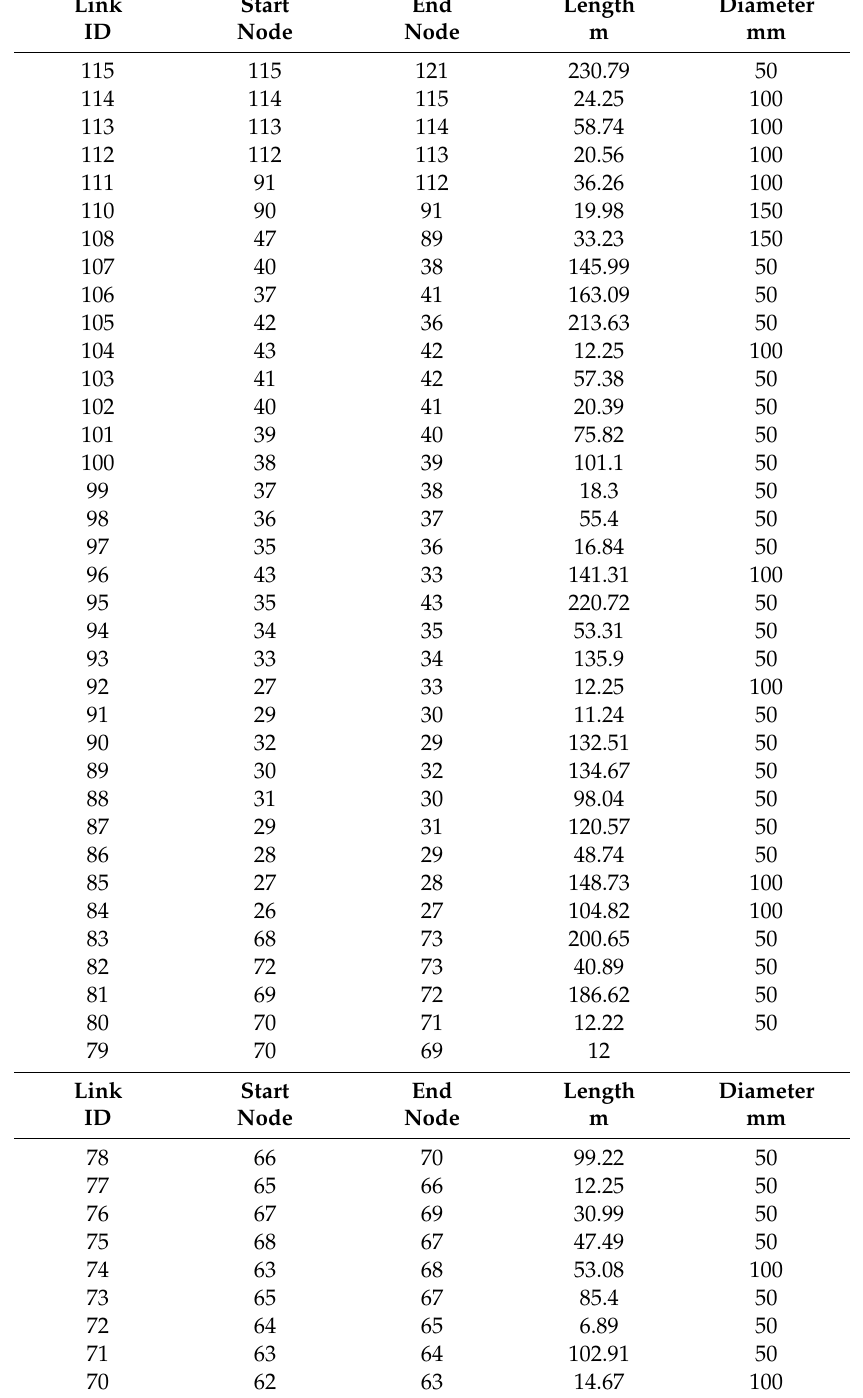
Table A1. Pipeline dimensions of the Campos do Conde II water distribution network,